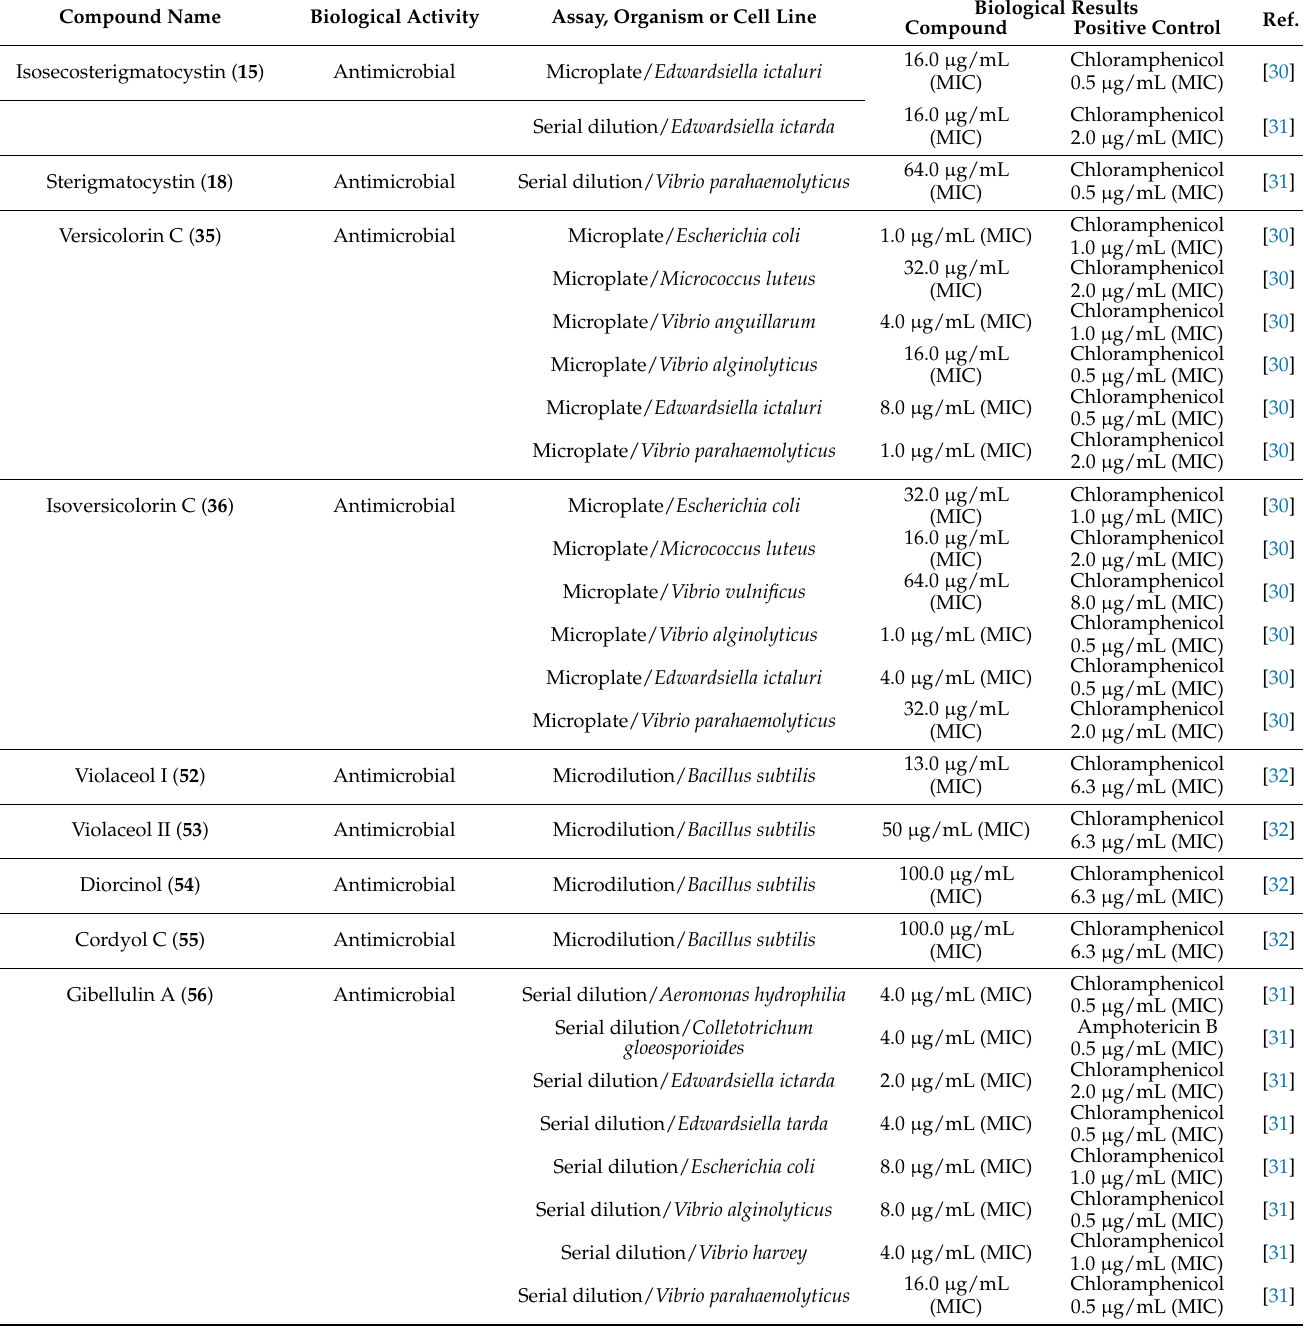
Table 1. Biological activity of reported metabolites from Aspergillus nidulans